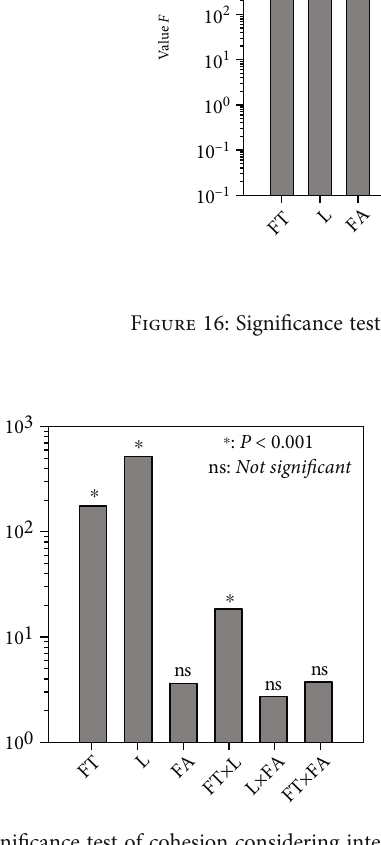
Figure 17: Signi fi cance test of cohesion considering interactions.